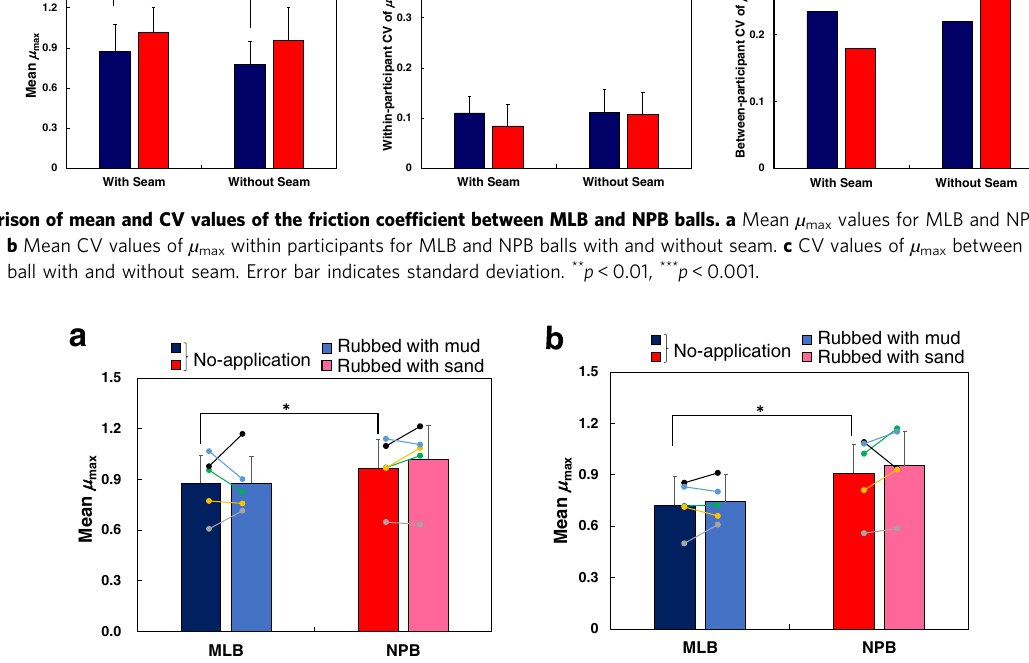
Fig. 7 Effect of rubbing with mud/sand on the friction coef fi cient. a Mean µ max of seamed MLB and NPB balls with and without rubbing with mud/sand. b Mean µ max of seamless MLB and NPB balls with and without rubbing with mud/sand. Each plot indicates the mean µ max for each subject, while the error bar indicates standard deviation. * p <